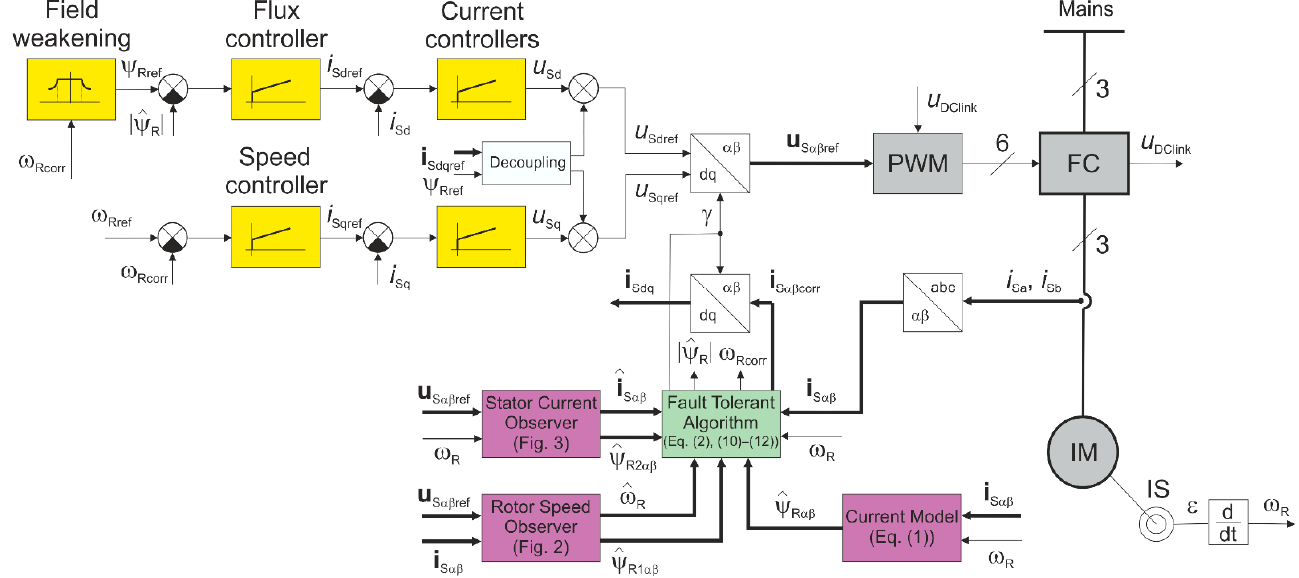
Figure 1. Block diagram of speed and current sensor fault-tolerant DFOC-based induction motor drive.